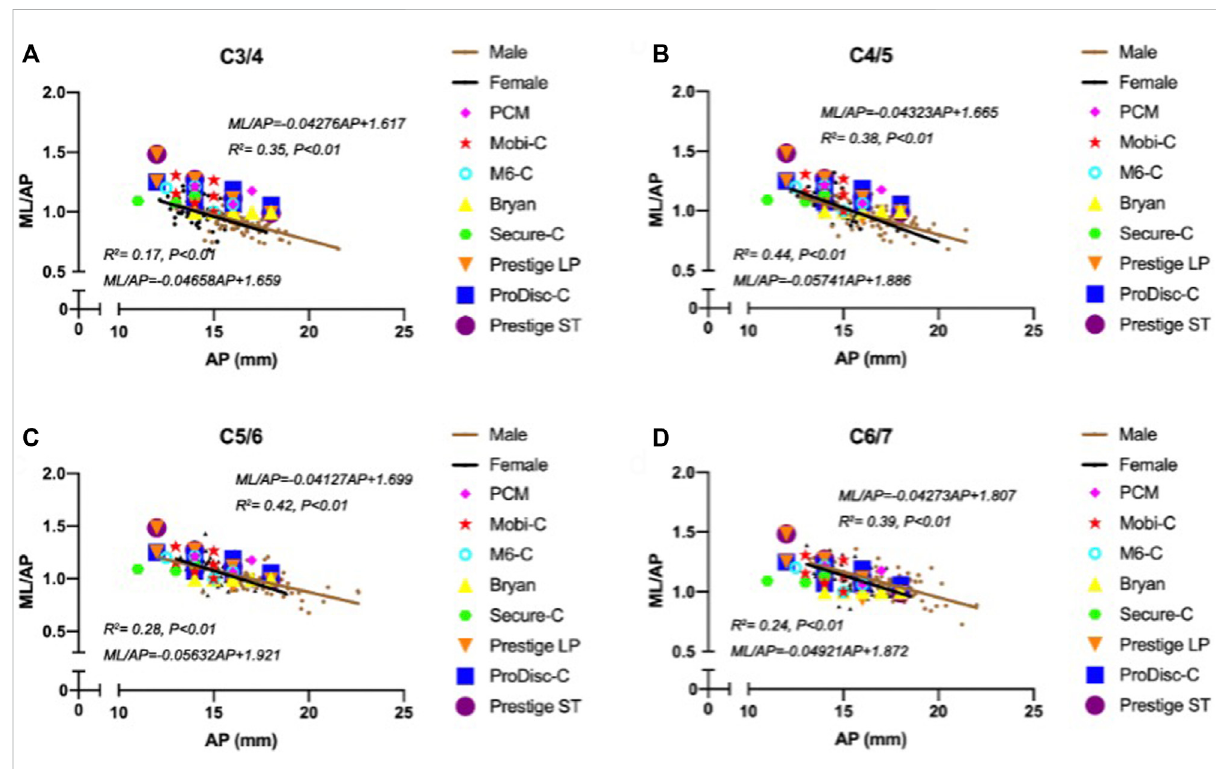
FIGURE 5 Mismatch of the width-to-depth ratio between cervical anatomical data and